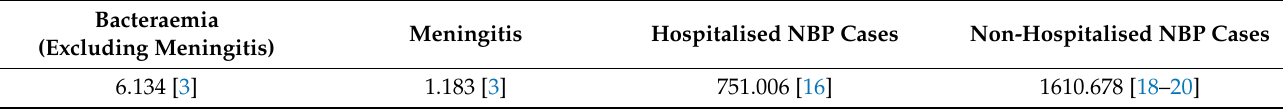
Table 1. Disease incidence (people aged >64 years): rates per 100,000 inhabitants.